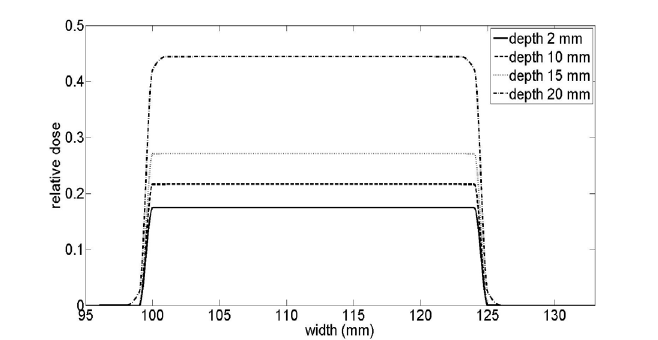
Fig. 9. Lateral profiles for a 25x25 mm 2 proton beam of 50 MeV in water at depth 2,10,15 and 20 mm.